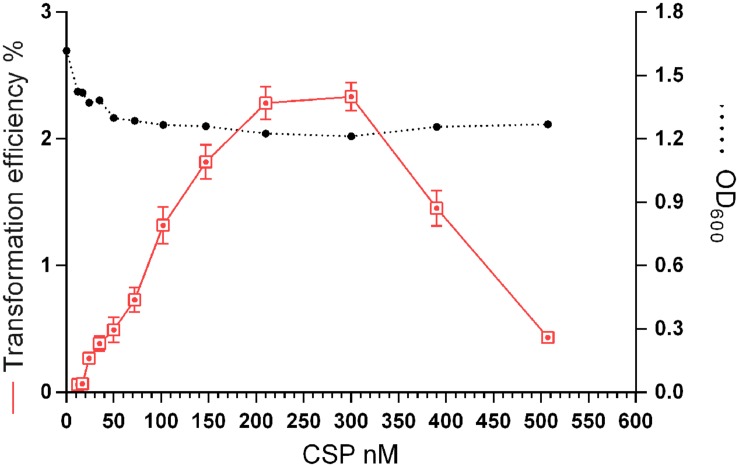
Effect of CSP concentration on transformation efficiency and culture density. S. mitis type strain pre-culture at OD600 0.5 was diluted 1:100 in C+YY B and grown until OD600 0.04 at 37°C in 5% CO2. Following, 500 μL aliquots were exposed to 150 ng mL-1of the 7 kb amplicon donor (aRJ21) and CSP concentrations varying from 0 to 507 nM. Cultures were further incubated in closed tubes for 4 h at 37°C in air atmosphere. Optical density of the cultures was measured at the time of plating. The % of CFU containing KanR transformants was determined by plating on blood plates with or without 500 μg mL-1 kanamycin. The results are averages from 3 replicates and representative of three independent experiments. Error bars represent standard error of the mean.